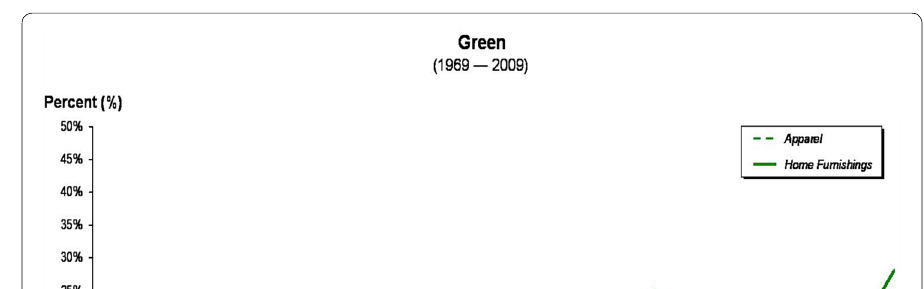
Fig. 5 Blue: incidences of blue in home furnishings and apparel